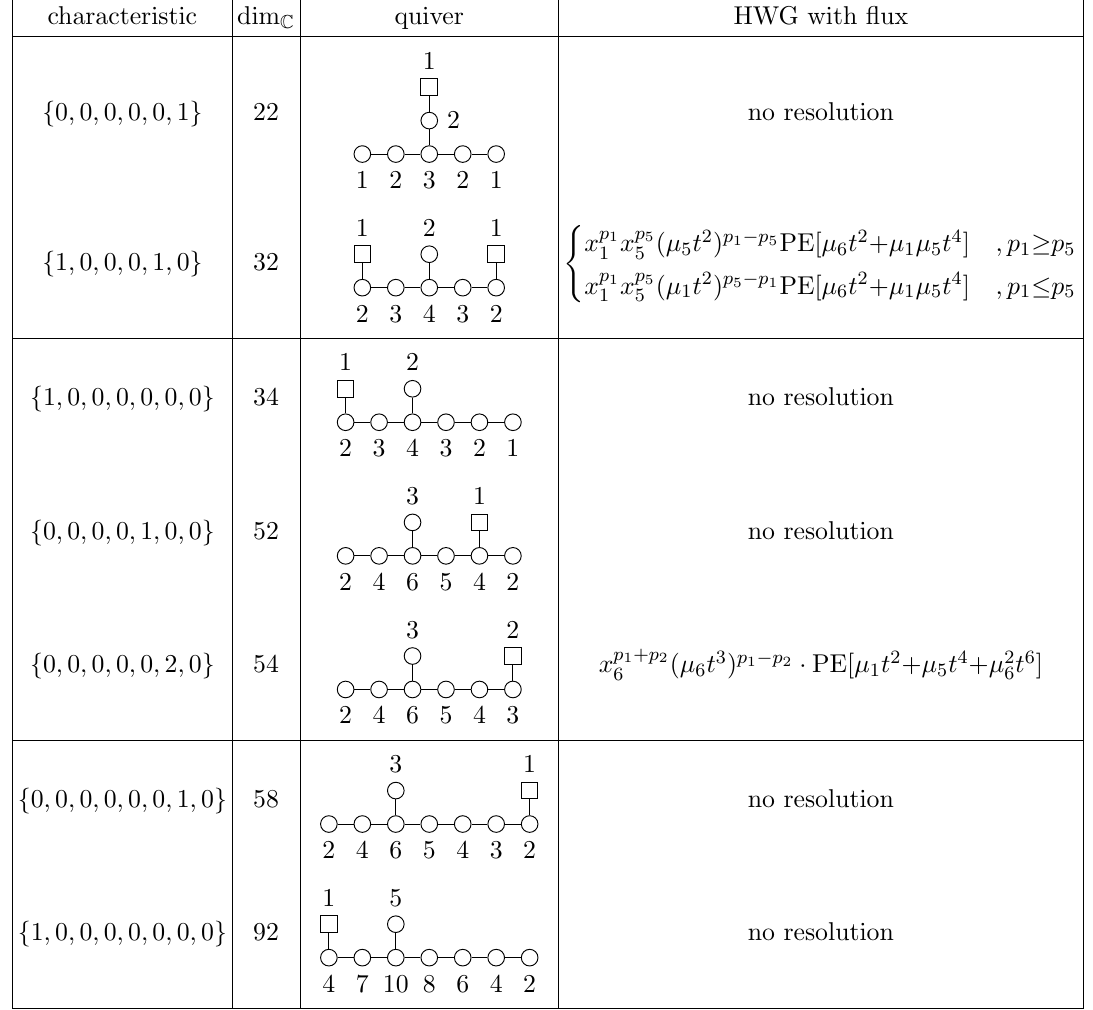
251 no resolution Table 8 . Coulomb branch quiver gauge theories for the exceptional algebras E 6 , E 7 , E 8 : realisations of the (closures of the) nilpotent orbits of characteristic height two. The unphysical U(1) in G F can be eliminated as before: introducing an auxiliary fugacity z 0 for U(1) (cid:26) G F , and imposing P j p j z